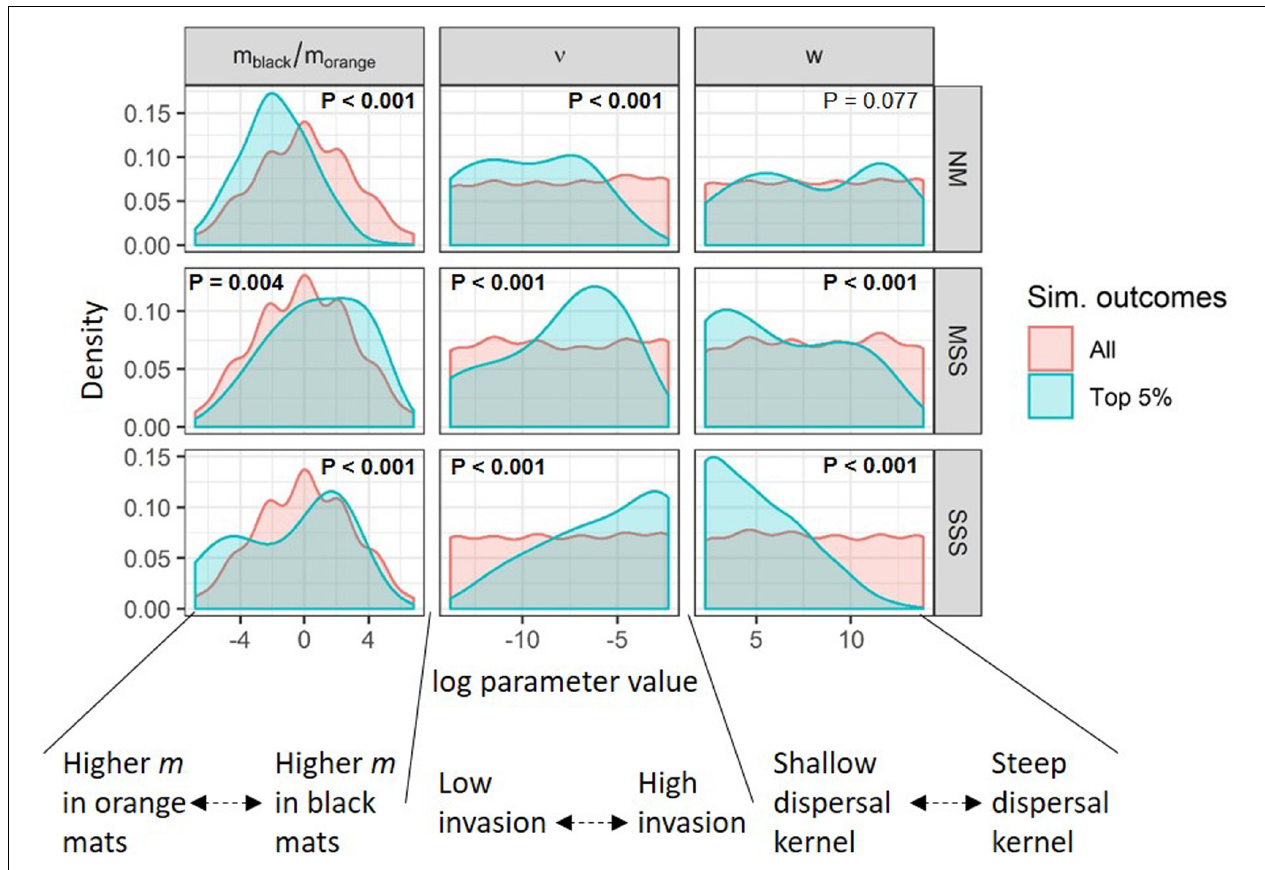
FIGURE 8 | Distribution of metacommunity parameter values (log transformed, x -axis) used in All (red) and the top 5% most plausible (blue) simulated metacommunities for neutral model (NM, top row), moderate species sorting (MSS, middle row), and strong species sorting (SSS, bottom row) simulation scenarios. Metacommunity parameters represent disparity in immigration between black and orange mats ( m black / m orange , left column), invasion rate by novel taxa ( ν , middle column), and dispersal kernel slope ( w , right column). P -values are from a two-sample Kolmogorov–Smirnov test, used to compare the distribution of parameter values in the top 5% simulations against the total population of parameter values across all simulations represented in each